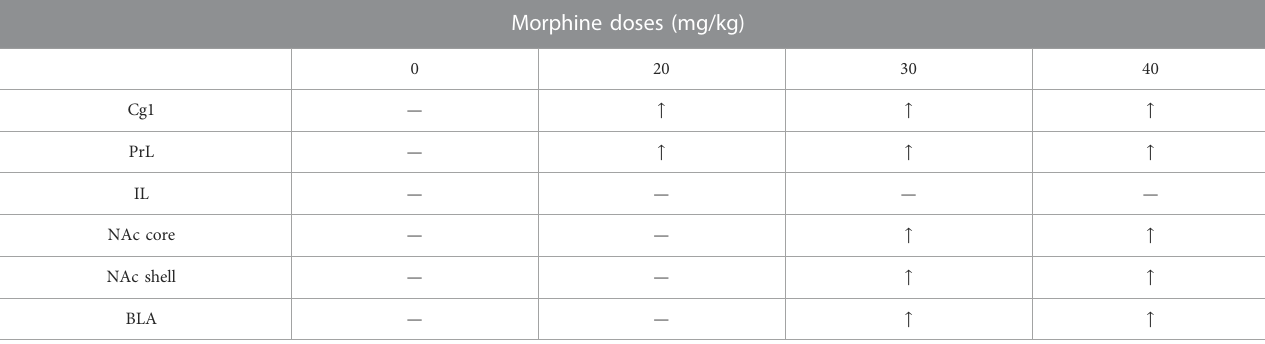
TABLE 1 Summary of c-Fos (%) in speci fi c brain areas for various doses of morphine injections after morphine-induced conditioned taste aversion (CTA).